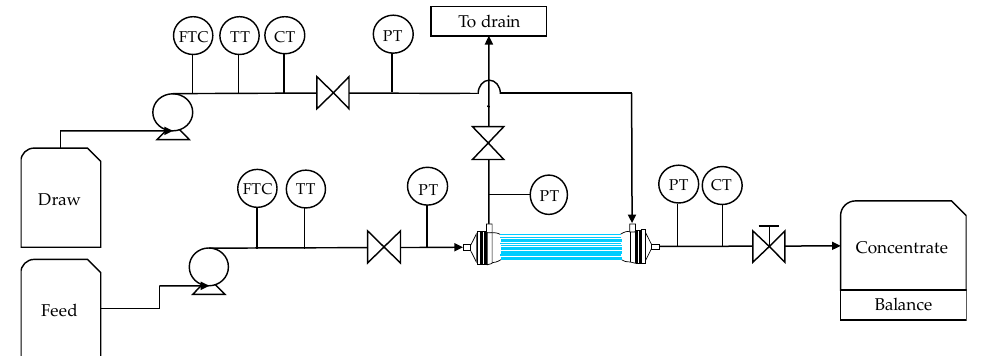
Figure 1. Flow diagram of the Titan OSMO Inspector set up during testing of hollow fiber forward osmosis (HFFO) modules. Flow transmitter controller (FTC), temperature transmitter (TT), conductivity transmitter (CT) and pressure transmitter (PT). Concentrate weight was recorded on a balance whereas diluted draw was discharged.